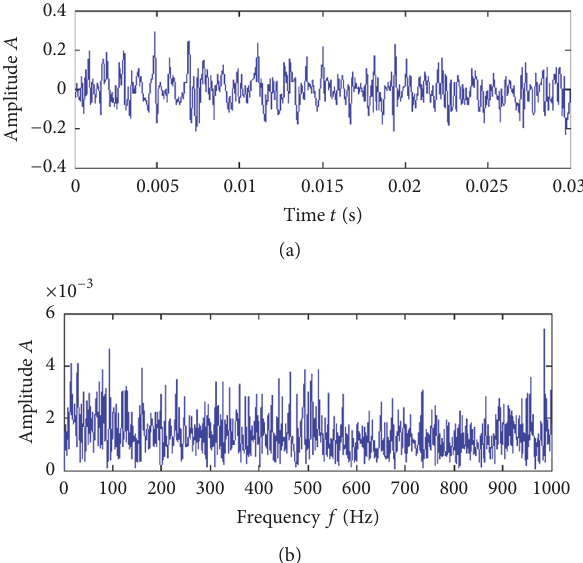
Figure 9: Vibration signal of early outer race fault: (a) time waveform and (b) envelope spectrum.